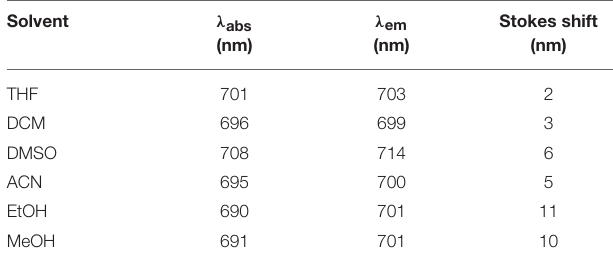
shapes are affected by the solvent polarity or proticity. Moreover, the small Stokes shift (5–10 nm) values indicate that a moderate geometry change occurs from the ground to the excited state.